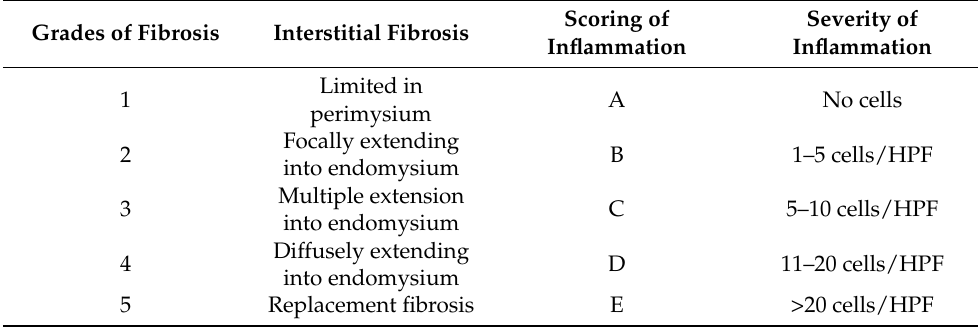
Figure 2. Histopathological assessment of inflammation and fibrosis. LAD tissue was obtained from animals in all four groups and was qualitatively analyzed for the presence of fibrosis and myofibroblasts. Trichrome stains (10 × ) of the LAD region showed ( A ) a normal amount of interstitial fibrosis in controls, ( B ) an extensive presence of fibrosis in endomysium in HIB animals, ( C ) the focal extension of fibrosis in endomysium in CABG animals, and ( D ) a normal amount of fibrosis, similar to the control, in the CABG + MSC group. The presence of myofibroblasts was assessed using alpha-SMA stain (40 × ). ( E ) In the control group, there was an absence of alpha-SMA stain in the myocardial tissue beyond the expected smooth muscle in the blood vessels (showed by arrows). ( F ) The HIB group showed an increased number of myofibroblasts between bundles of myofibers (encircled by black dashed line). ( G ) The CABG group showed very few myofibroblasts associated with alpha-SMA stain (encircled by a black dashed line), and ( H ) the CABG + MSC group showed minimal to no myofibroblasts. Scale bars are 0.2 mm. CABG = Coronary artery bypass graft, HIB = Hibernating myocardium, MSC = Mesenchymal Stem Cells. Table 1. Qualitative assessment of fibrosis and inflammation in a swine model of hibernating myo- cardium using a scoring or grading system [20,21].